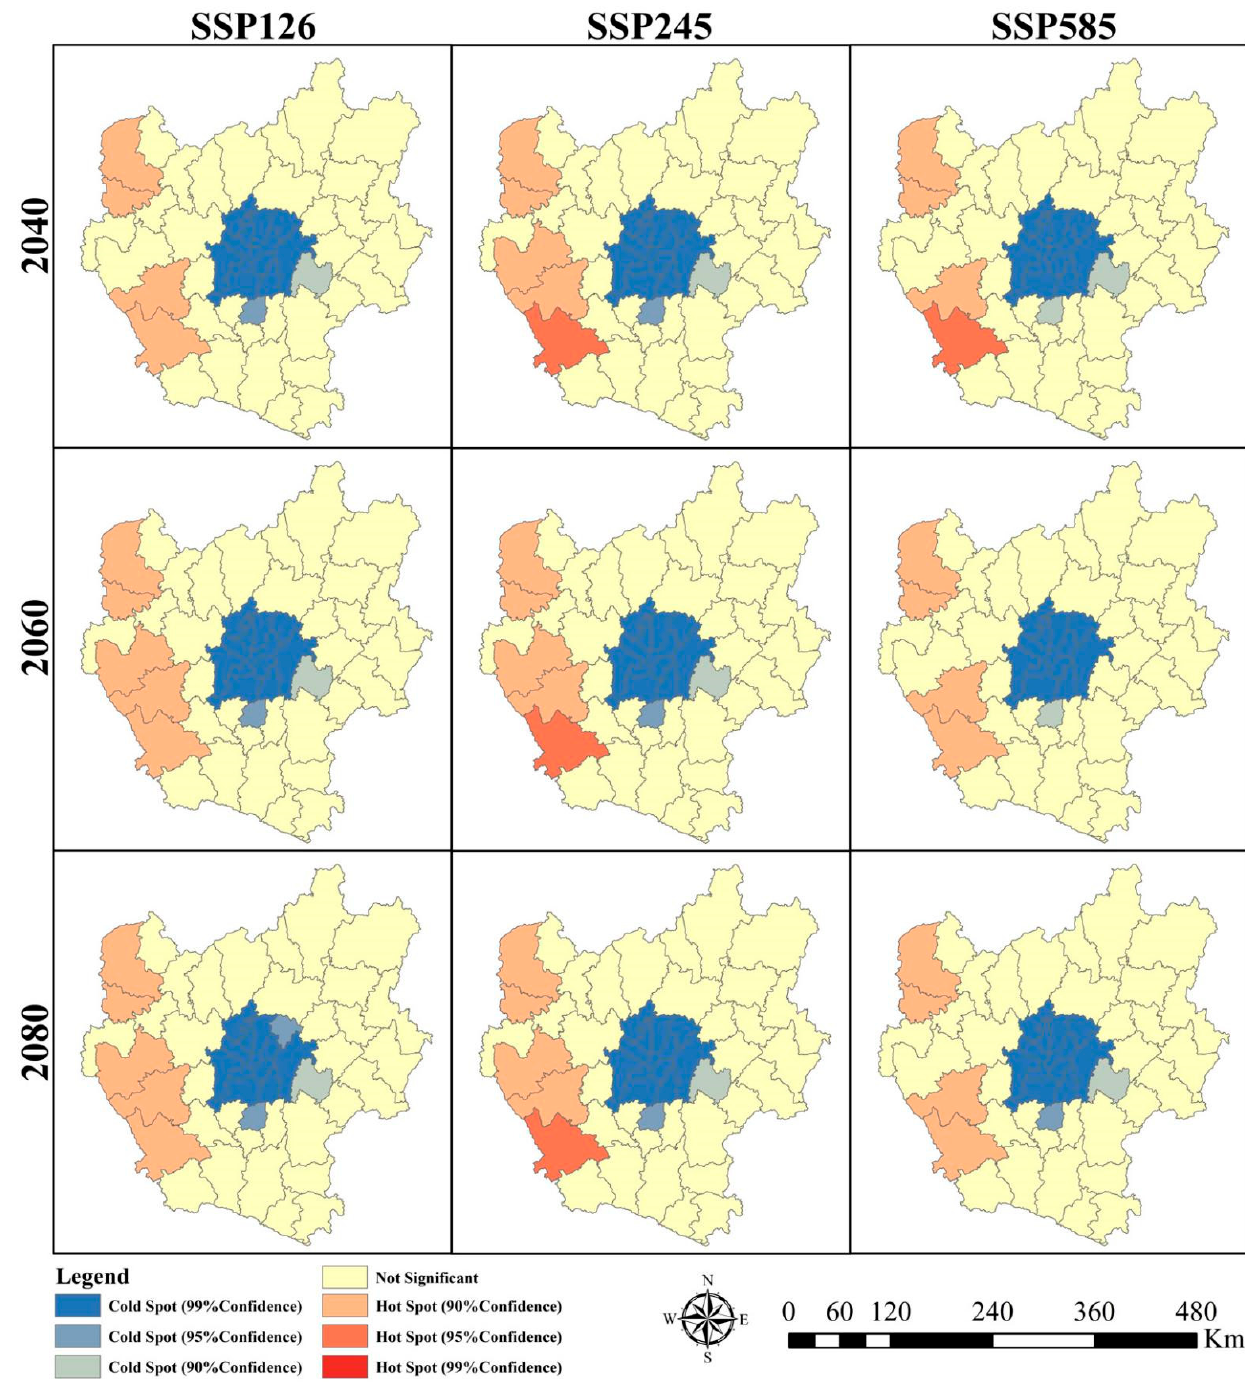
Figure 9. Distribution of hot and cold spots under different scenarios under climate